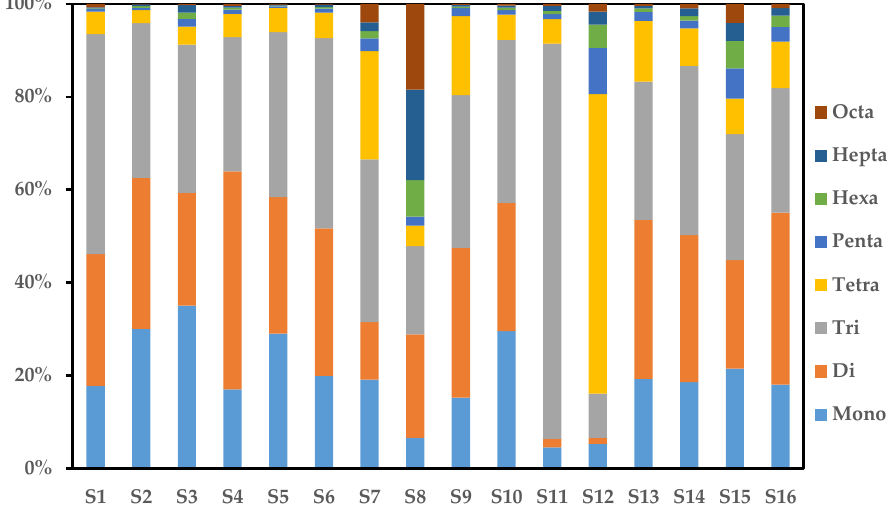
Figure 2. Homolog profiles of polychlorinated naphthalene in the sediment samples from the Yangtze River basin.